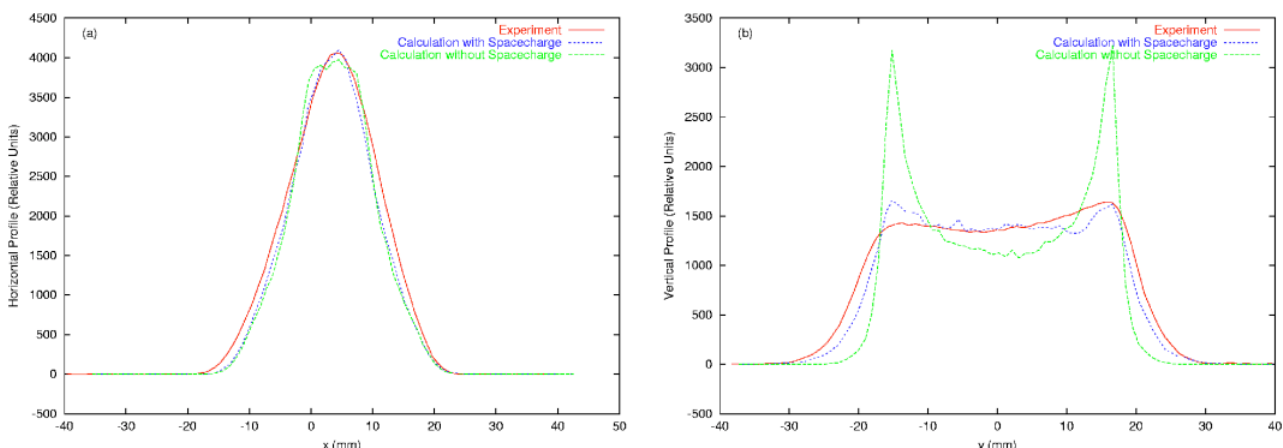
FIG. 4. (Color) The effect of the space charge force on the (a) horizontal and (b) vertical beam profiles, for the highest intensity case with no closed orbit bumps during injection. Red curve: experiment; blue curve: calculation with space charge; green curve: calculation without space